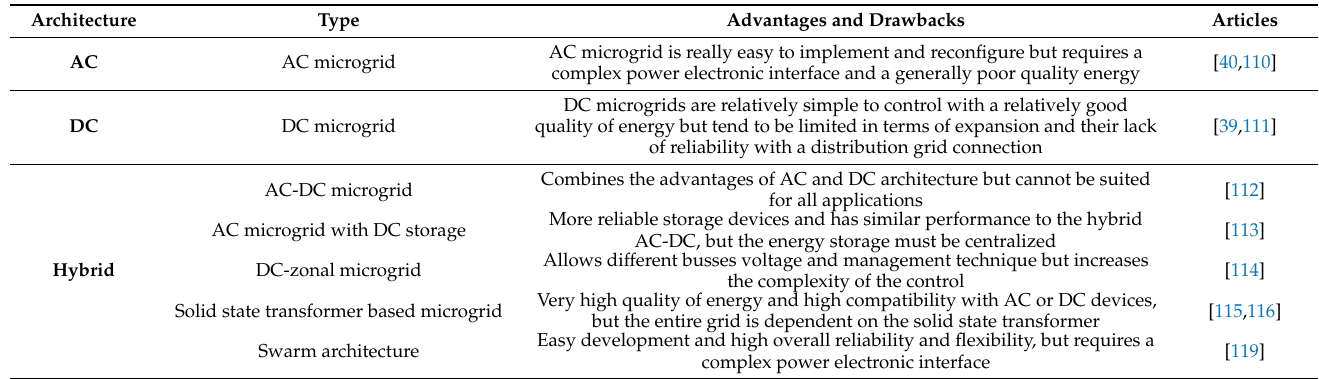
Table 3. Classification of microgrid power